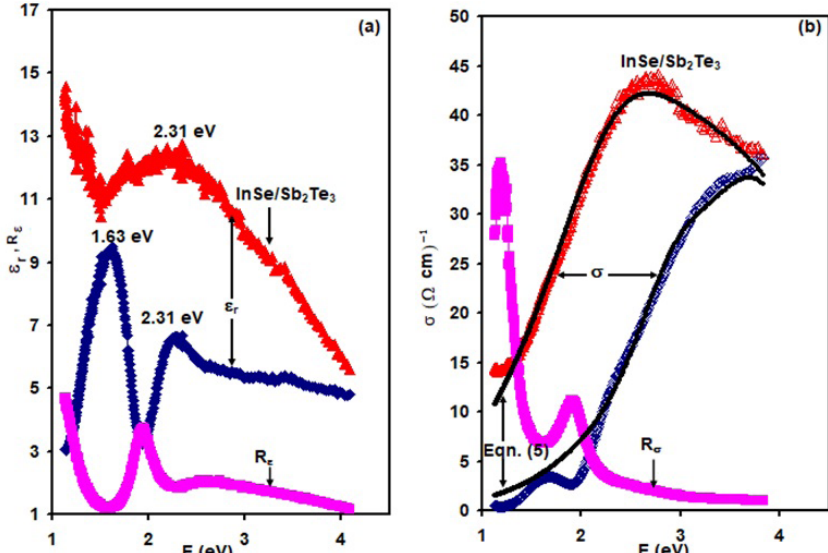
Te heterojunctions. 2 3